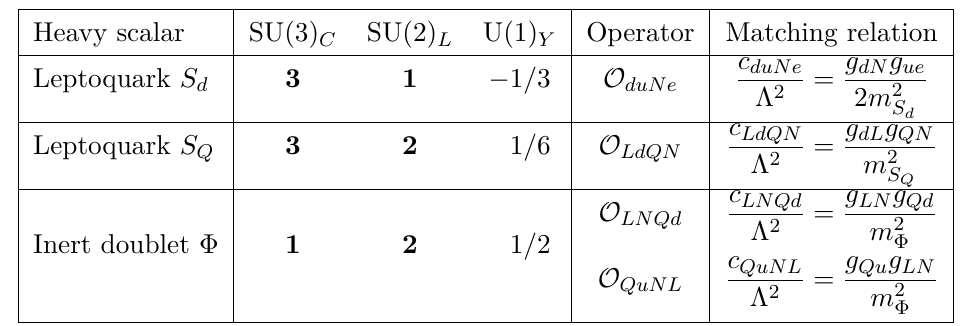
Table 2 . Heavy scalars with their gauge quantum numbers and the four-fermion single- N R op- erators they can generate. The last column reports the tree-level matching relations between the Wilson coefficients and the couplings of the UV